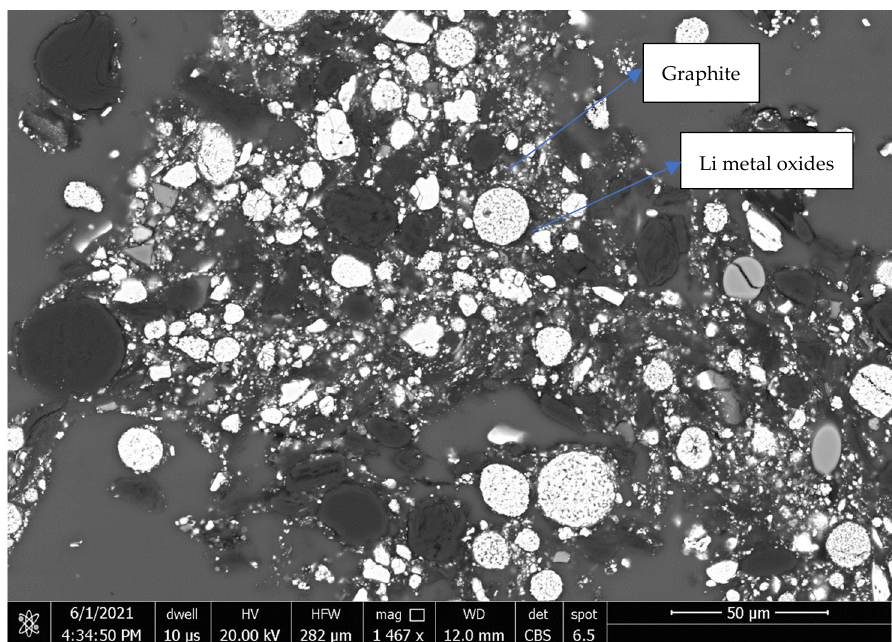
Figure 6. Back-scattered electron image of the fine fraction − 0.25 mm.